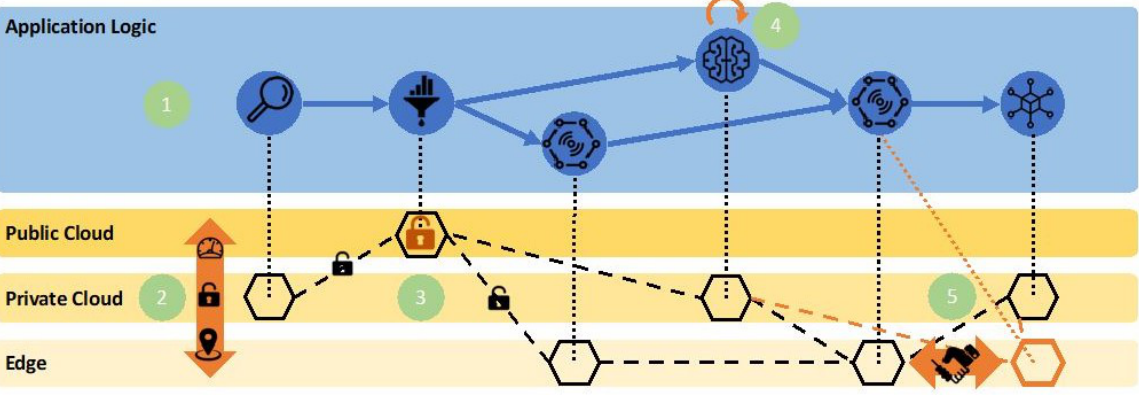
Figure 2. The five tasks of the Platform as a Service (PaaS) concept.